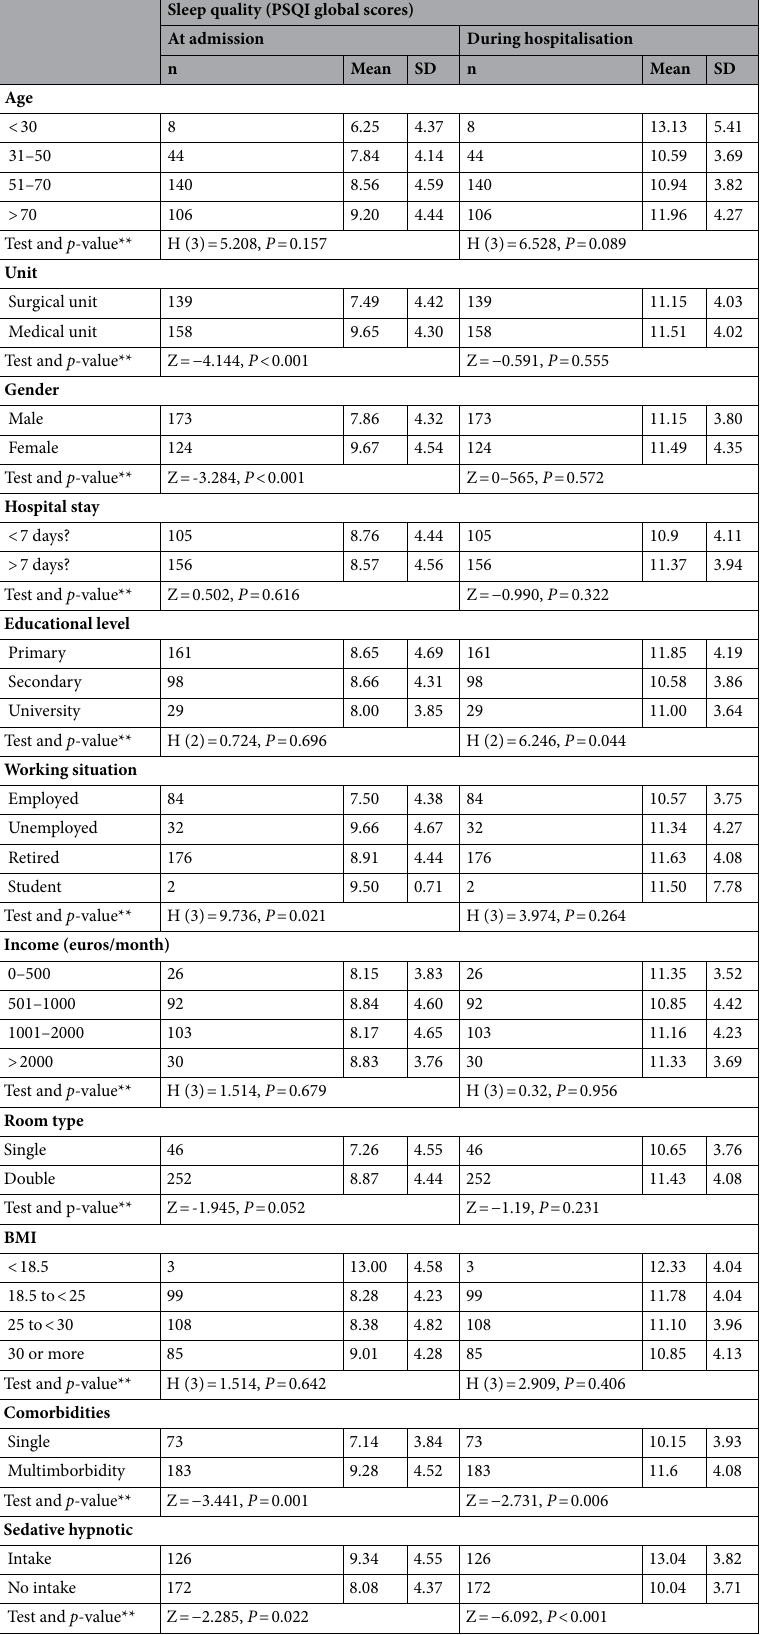
Table 3. Effects PSQI global scores and sleep quantity. **Student’s t test or